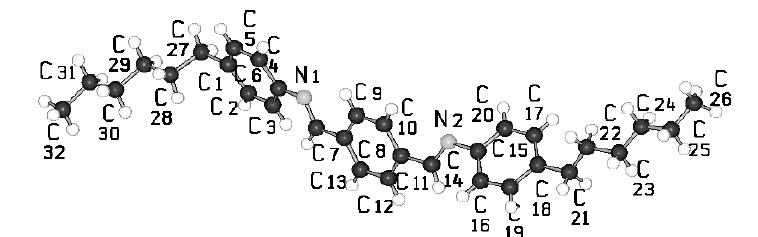
Figure 33. Representation of the conformation and numbering of atoms for TBAA-6 crystallizing in space group C2/c at ambient